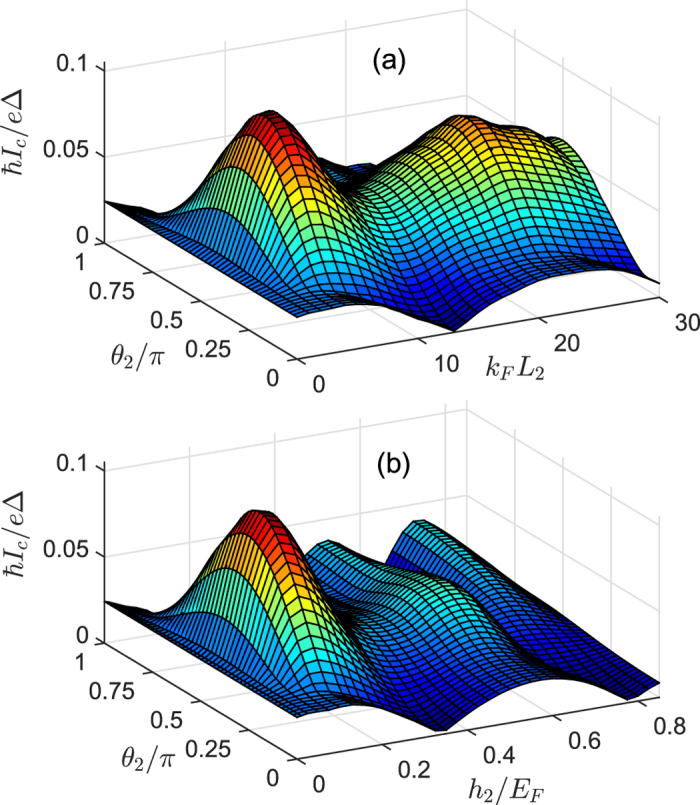
Critical current (a) as a function of  and θ2 for , and (b) as a function of  and θ2 for . We set , , and .